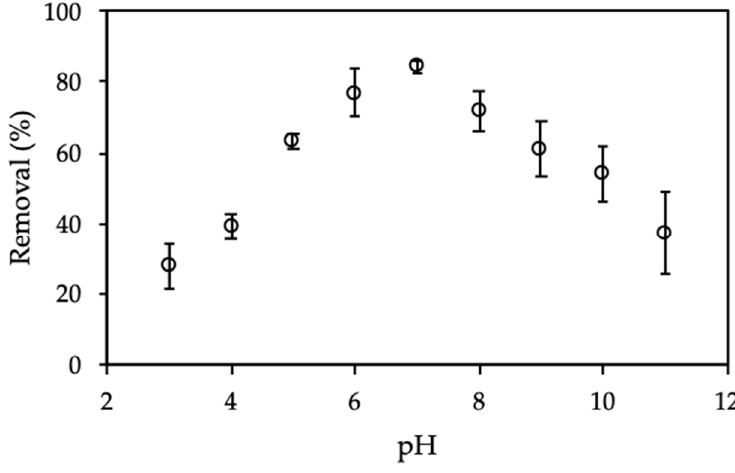
E ff ect of pH on removal of CFX using protein-modified nanosilica (ProMNS). Figure 7. Effect of pH on removal of CFX using protein-modified nanosilica (ProMNS). (C i (CFX) = 20 (C i (CFX) = 20 mg / L, contact time 90 min, adsorbent dosage 10 mg / mL, 1 mM KCl). Error mg/L, contact time 90 min, adsorbent dosage 10 mg/mL, 1 mM KCl). Error bars show standard deviations of three replicates.